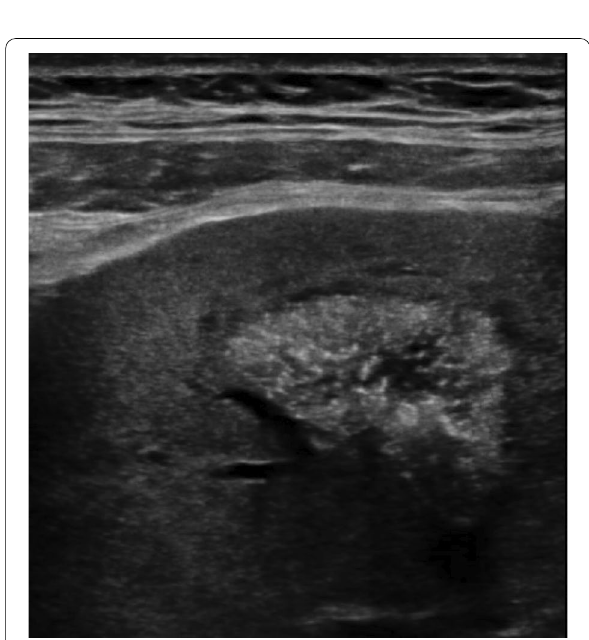
and multiple diffuse hyperechoic spots (calcifications, signed by yellow arrows)